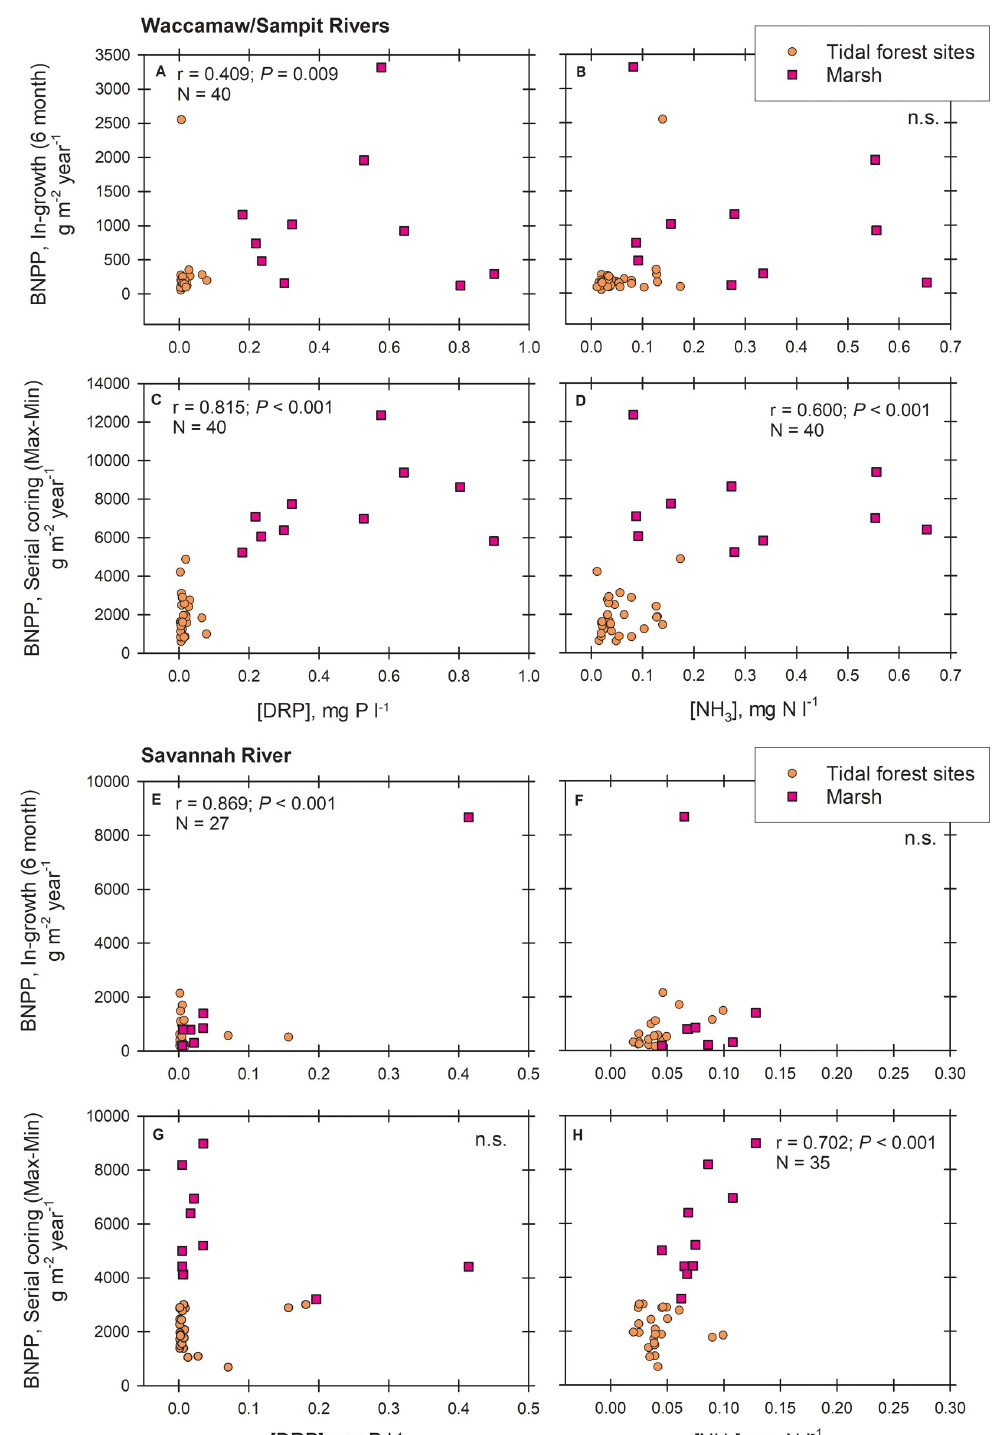
Fig 4. Correlation analyses of belowground net primary productivity (BNPP) versus porewater nutrient concentrations. Data are from the Waccamaw/Sampit Rivers, South Carolina, relating (A) 6-month ingrowth BNPP to Dissolved Reactive Phosphorus (DRP), (B) 6-month ingrowth BNPP to ammonia (NH 3 ), (C) Max-Min serial coring BNPP to DRP, and (D) Max-Min serial coring BNPP to ammonia (NH 3 ); and from the Savannah River, Georgia, relating (E) 6-month ingrowth BNPP to DRP, (F) 6-month ingrowth BNPP to ammonia (NH 3 ), (G) Max-Min serial coring BNPP to DRP, and (H) Max-Min serial coring BNPP to ammonia (NH 3 ) from TFFW transitioning to marsh. No significant relationships were found among porewater nutrients and other BNPP techniques used by